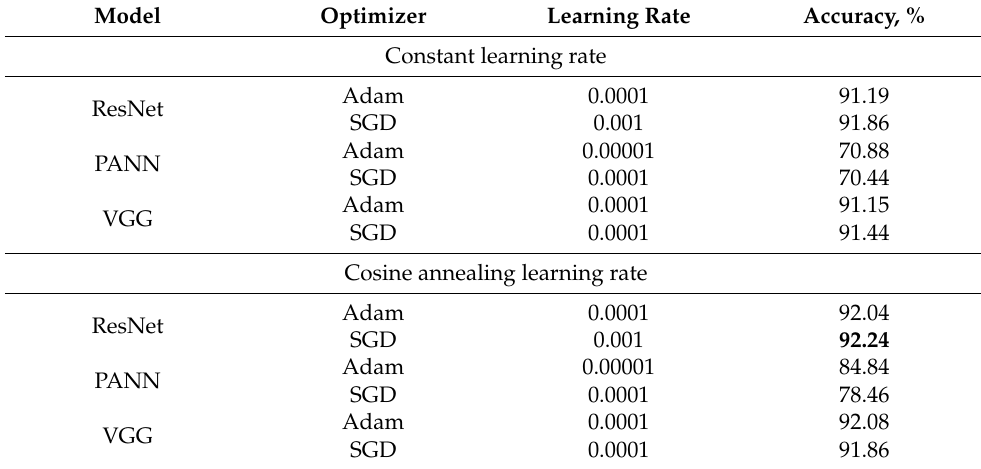
Table 6. Accuracy results of choosing the optimal audio